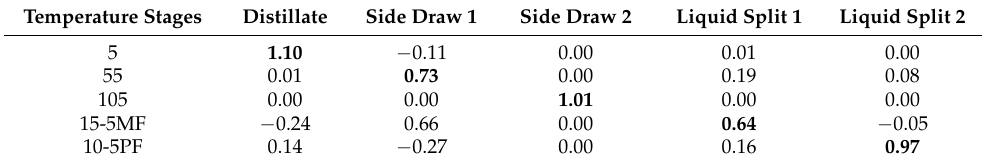
Table 6. RGA analysis for mixture